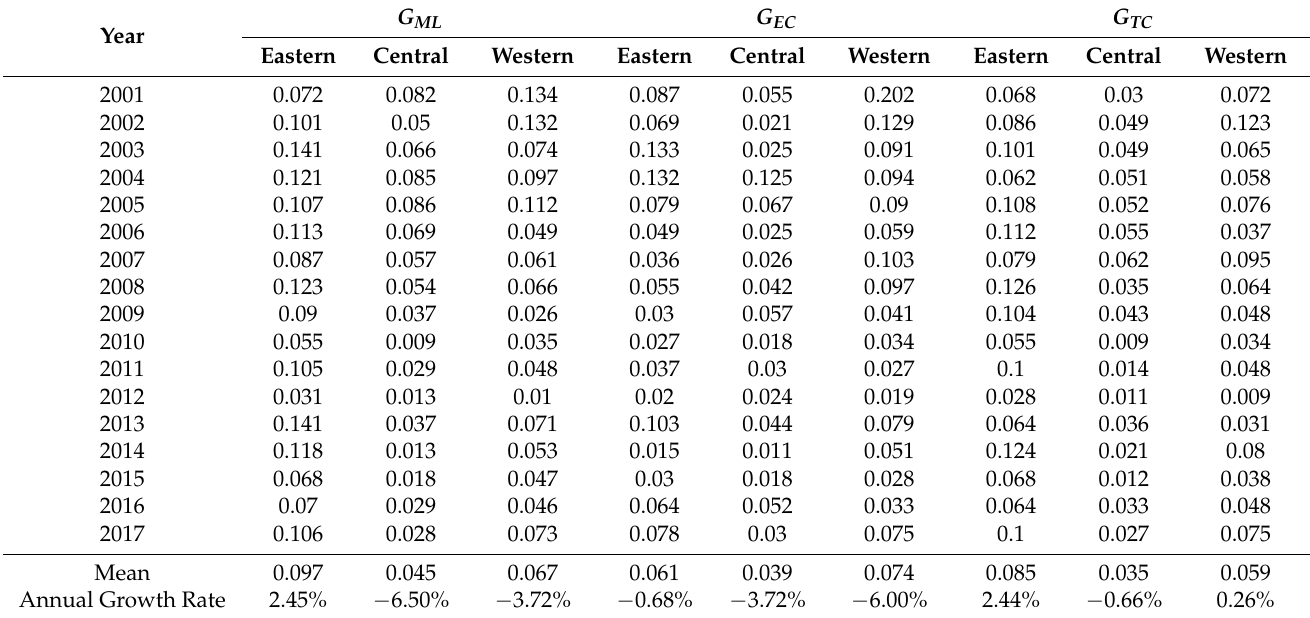
Table 4. Intra-group Differences in ML , EC , and TC of